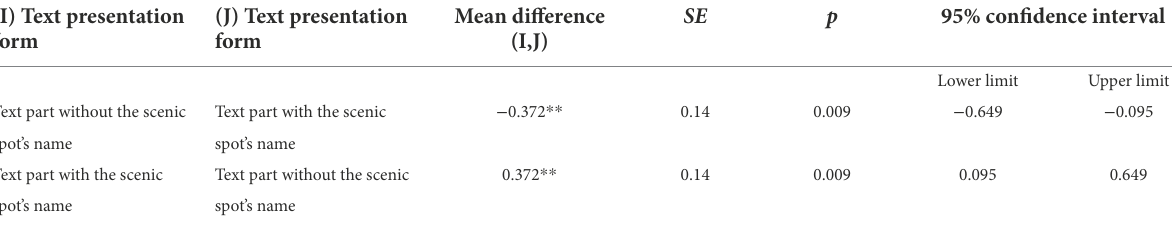
TABLE 4 Pairwise comparison of text presentation